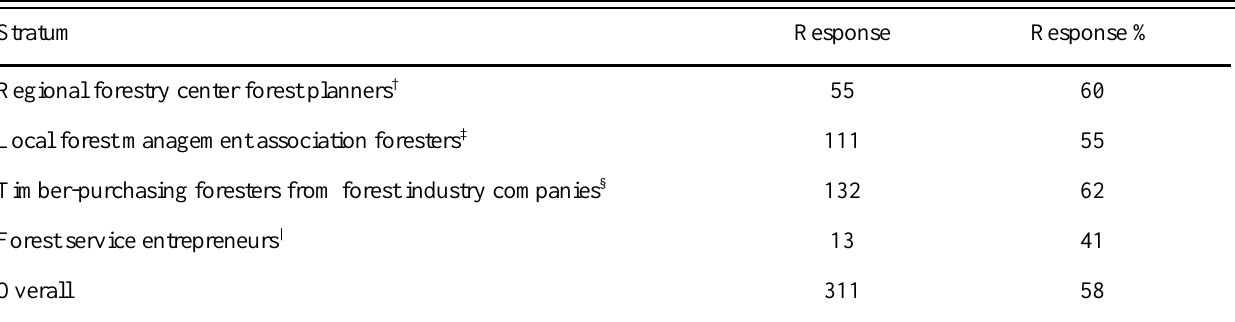
Table 1. Responses from different